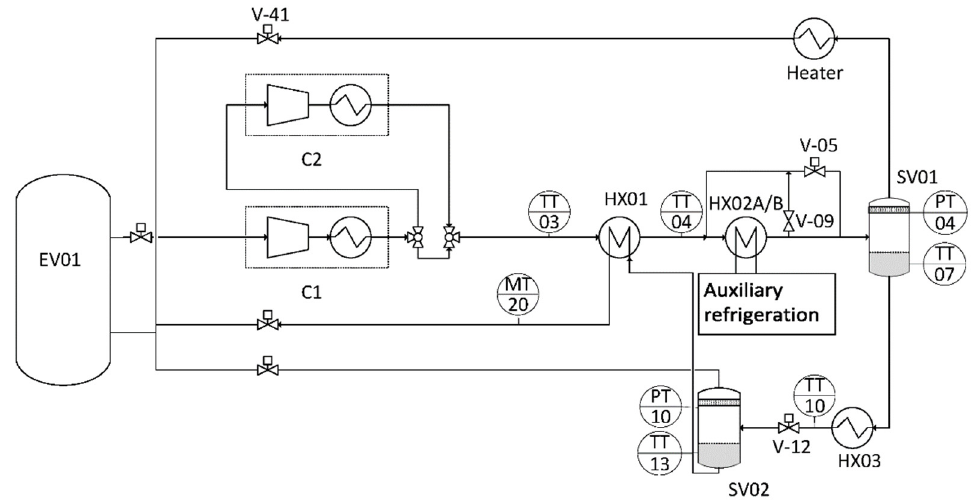
Figure 1. Process flow diagram of the experimental setup. Table 1. Relevant characteristics for a selection of the components in the process.